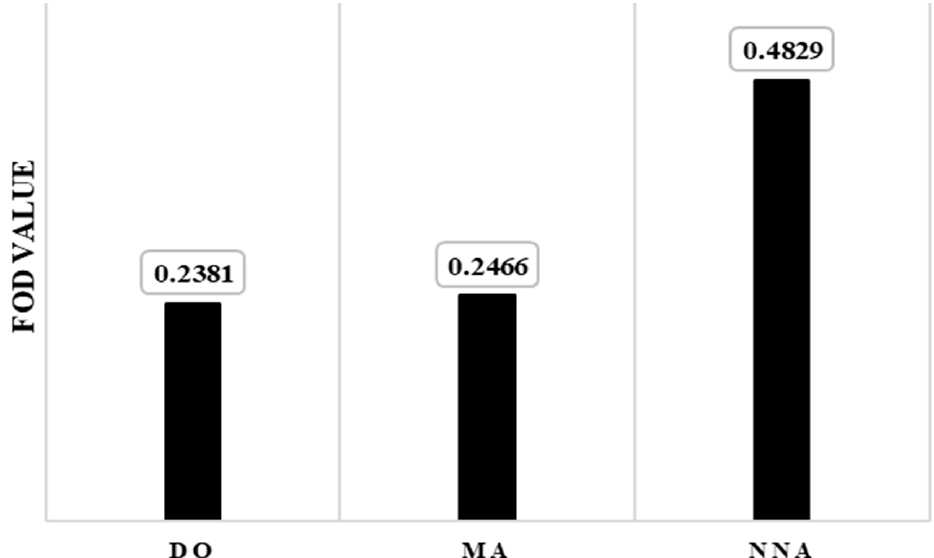
Figure 7. The cost function value based on each technique. Table 2. The realistic data of the AV.